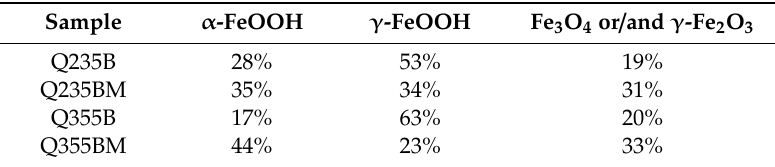
Table 2. The relative content of corrosion products of steel